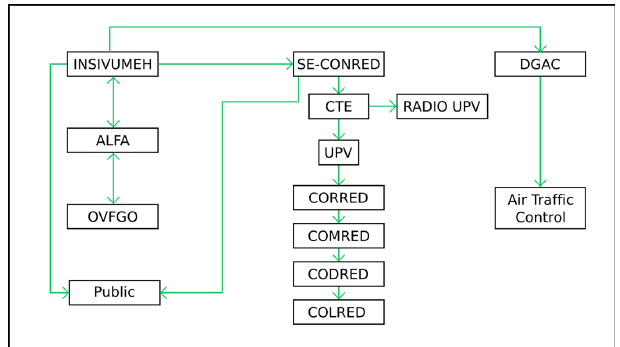
Figure 1: Schematic of di ff erent institutions and com- munities a ff ected by activity of Volcán de Fuego show- ing pathways of communication between them. Dia- gram co-created by G. Chigna, W. Chigna, and A. Nai-